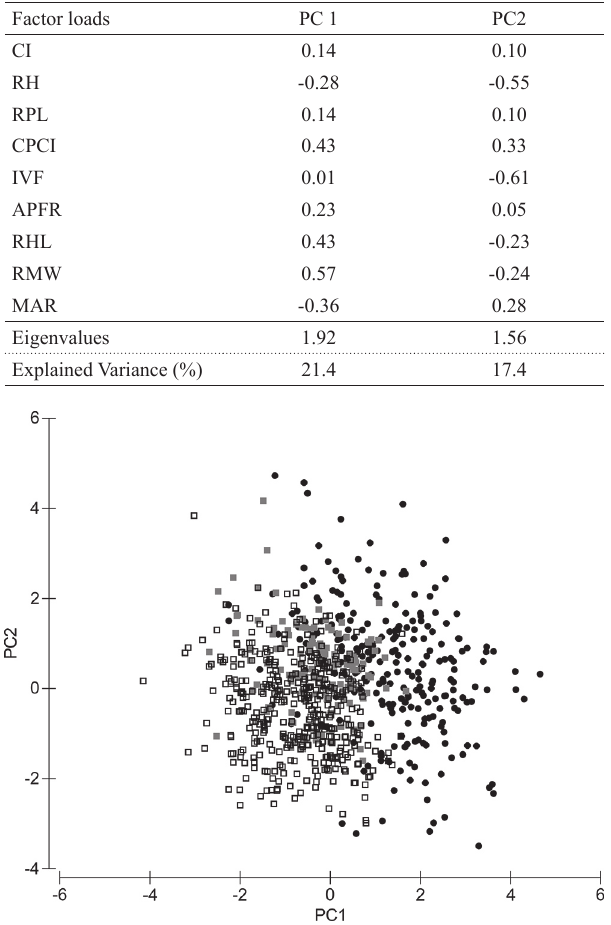
Fig. 6. Ordination diagram from the first two principal components for the functional traits of Atherinella brasiliensis in Mamanguape river estuary. Symbols size classes: Small juveniles (Open Black Square); Juveniles (Gray Circle) and Adults (Black